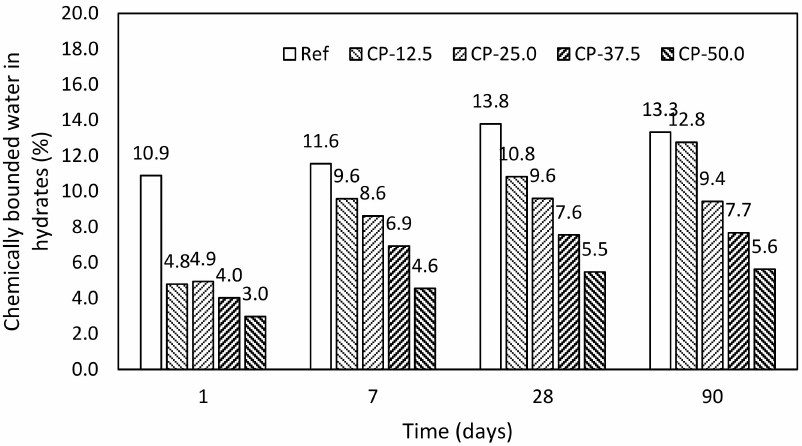
Figure 6. Chemically bounded water in hydrates—pastes with ceramic